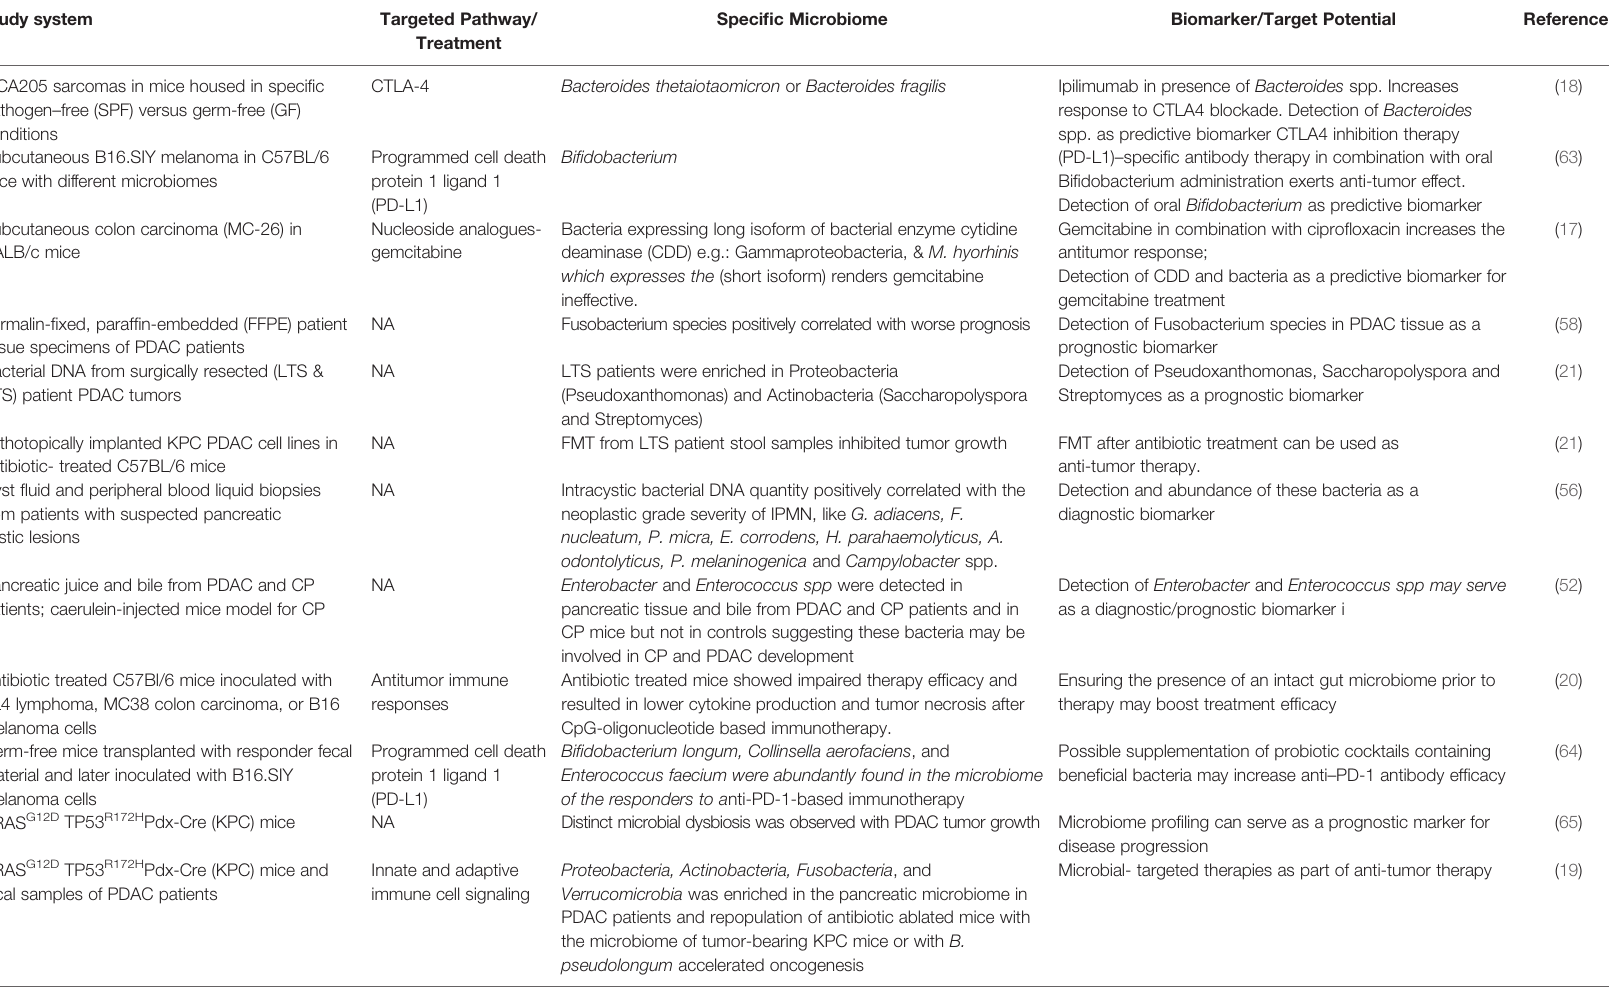
TABLE 1 | Compilation of studies on the impact of the microbiome in cancer progression and drug resistance as well as its potential as a biomarker or therapeutic